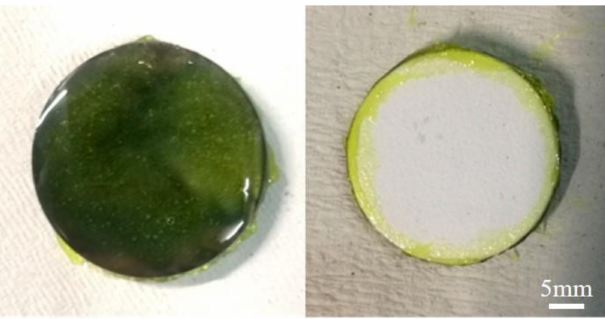
Figure 3. Edge treatment of the coating before immersion corrosion.